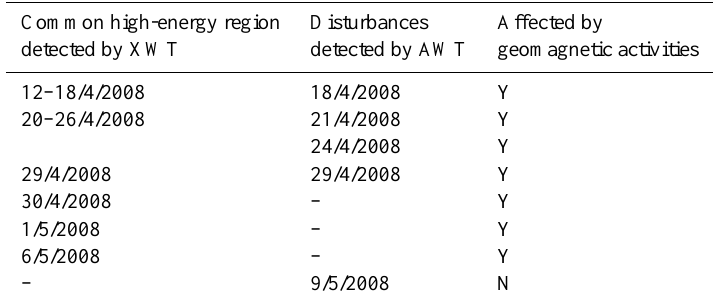
Table 2. The relationship between the ionospheric anomaly variations and the geomagnetic activity before the Wenchuan earthquake from 13 April 2008 to 12 May 2008. Common high-energy region Disturbances Affected by detected by XWT detected by AWT geomagnetic activities 12–18/4/2008